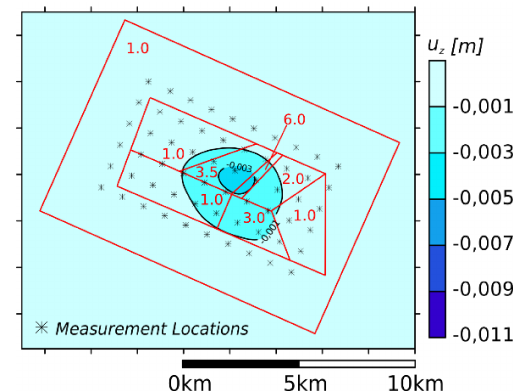
Figure 7. Test case 1: prior and Posterior CDFs from the updated f CM